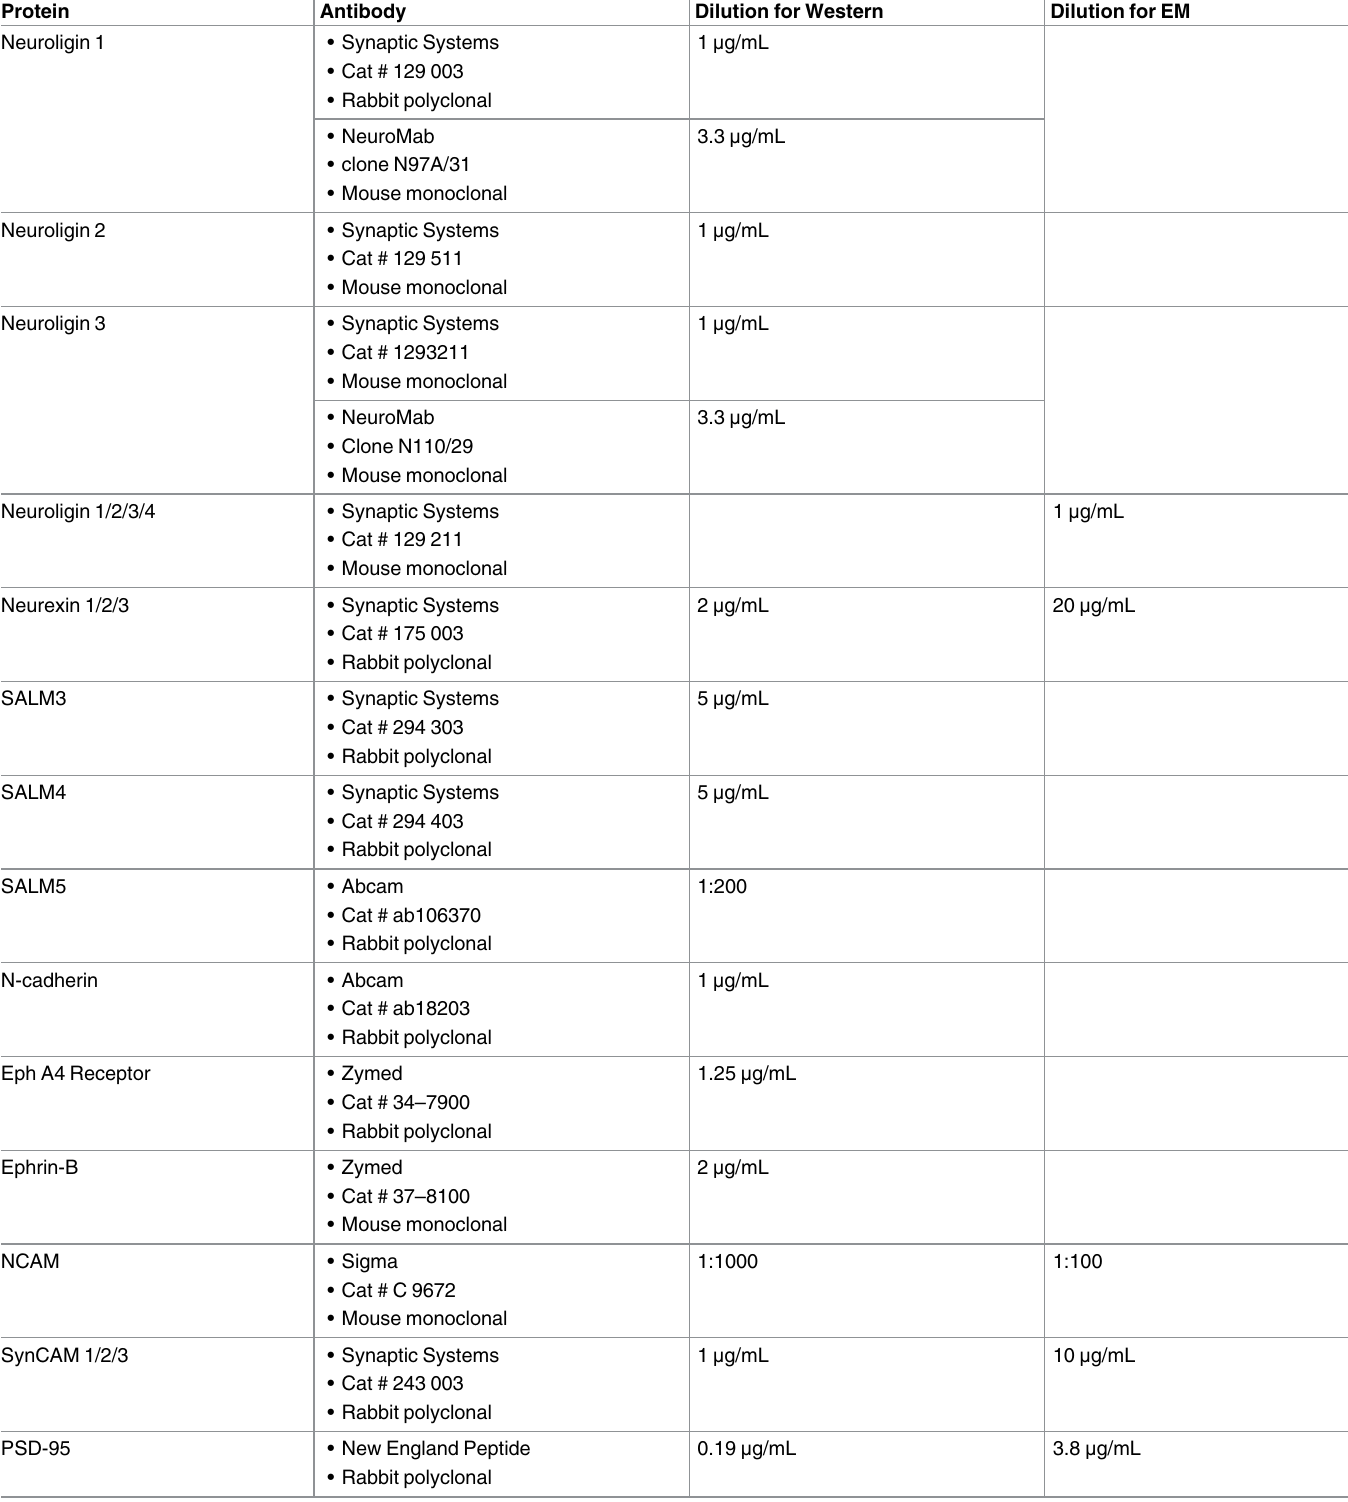
Table 1. List of